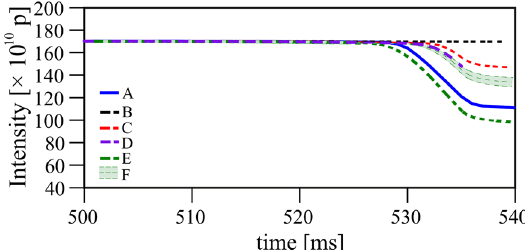
FIG. 20. The dynamic approach to Q y ¼ 4 in case of corrected COD: intensities vs time with vertical boundaries at (cid:2) 29 . 5 mm. Legend: (A) Measurement; (B) Simulation without space charge; (C) Simulation with direct space charge; (D) Simulation with space charge (with boundaries) without field errors; (E) Simu- lation with space charge (with boundaries) and measured quad- rupolar field errors; (F) Simulation with space charge (with boundaries) and random quadrupolar field errors distributions. (rectangular with dimensions (cid:2) 61 mm × (cid:2) 29 . 5 mm), slightly overestimates them (dashed green line). Different error distributions generate different intensity results: the green error bar represents the simulations behaviour in case a random error set of quadrupolar field errors is chosen, while the simple dashed green line is a similar simulation, but using the errors as they have been calculated on the real machine through the LOCO analysis. The dashed purple line represents the intensity profile obtained in case no field errors are considered.